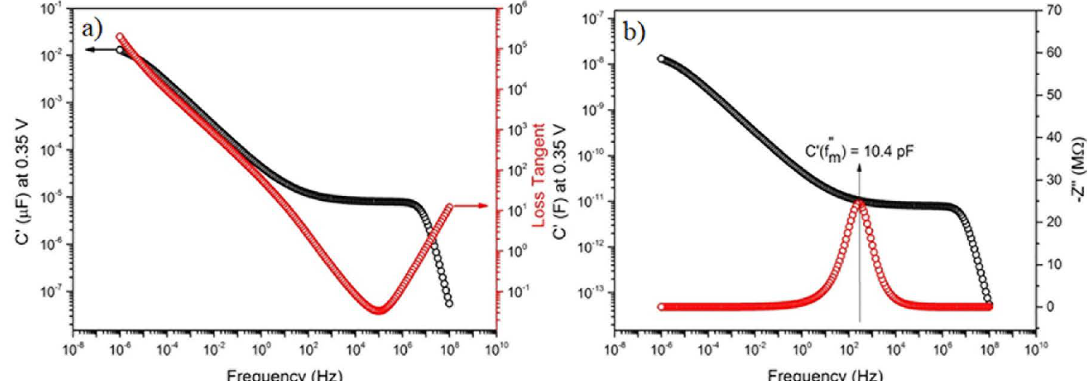
Figure 7. Simulation of capacitance and loss tangent (a) and capacitance and complex impedance versus frequency in the range from 1 µHz to 100 MHz (b).